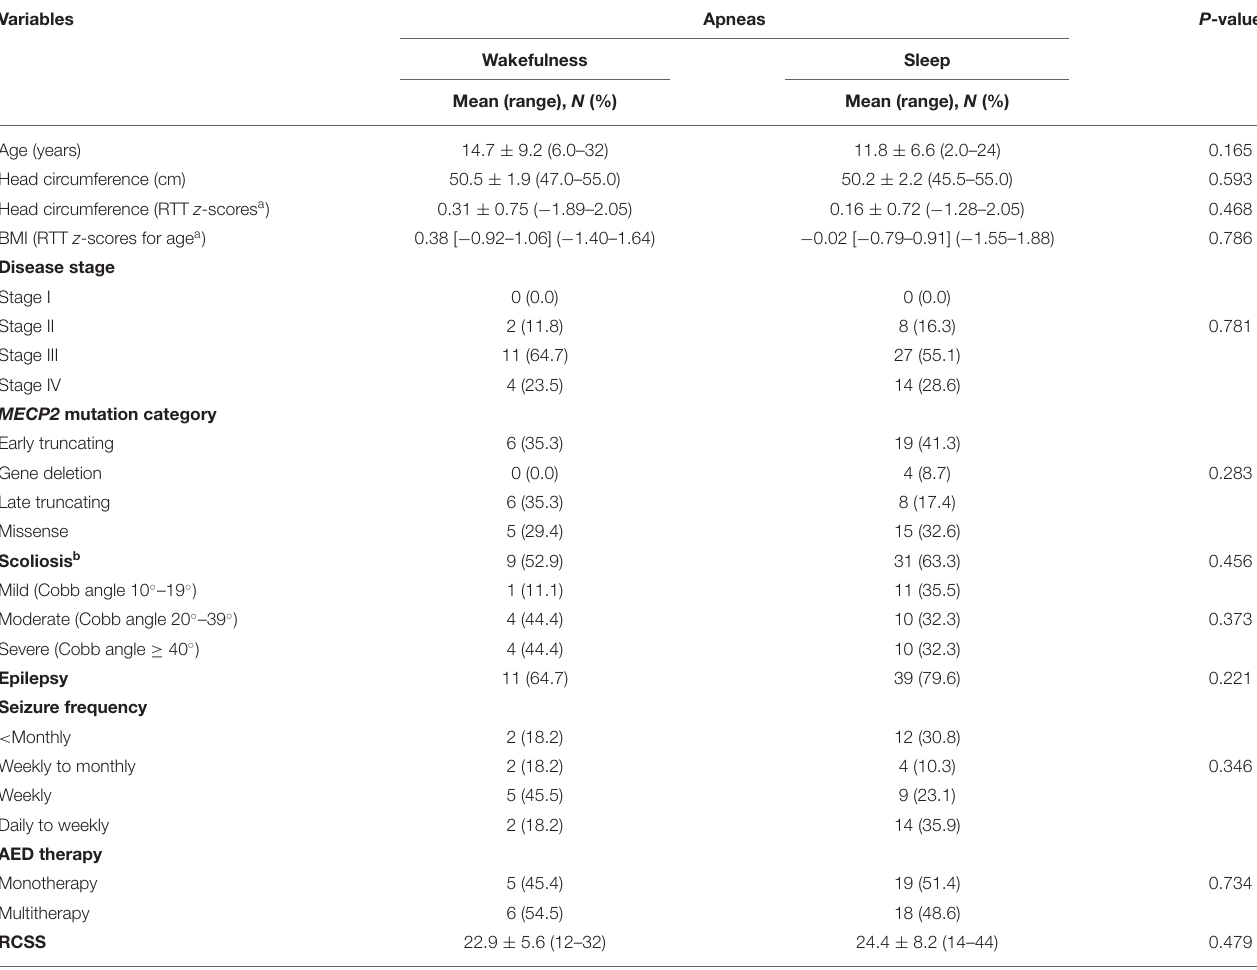
TABLE 5 | Demographic and clinical characteristics of the examined population with RTT as a function of wakefulness ( n = 17) vs. sleep apneas ( n = 49). Variables Apneas P